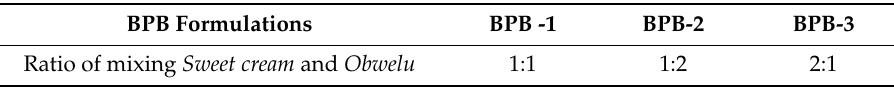
Table 1. Ratio of mixing Sweat cream and Obwelu to formulate bean pumpkin blend BPB Formulations BPB -1 BPB-2 BPB-3 Ratio of mixing Sweet cream and Obwelu 1:1 1:2 2:1 BPB: Common Bean Pumpkin Blend.